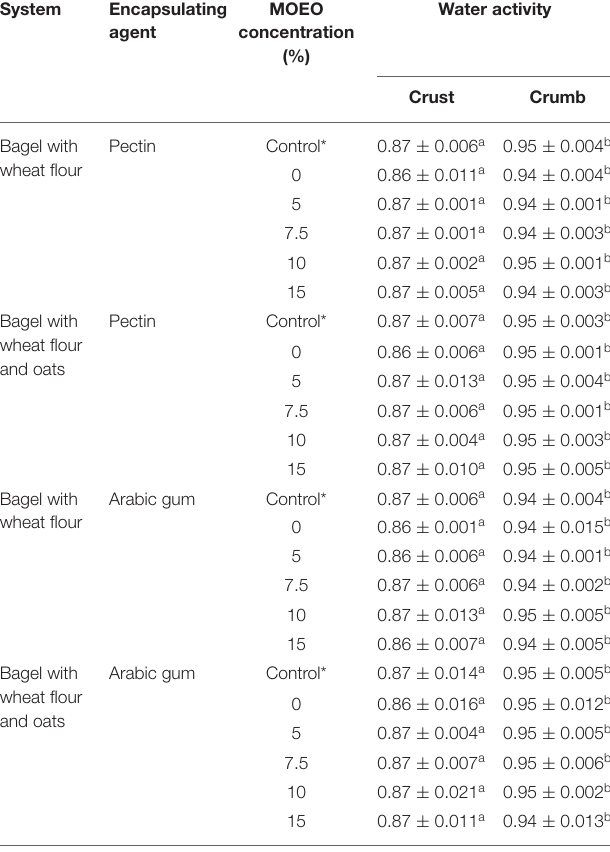
TABLE 4 | Water activity of crust and crumb of different formulations of bagels atomized with emulsions stabilized with pectin or Arabic gum at different concentrations of Mexican oregano essential oil (MOEO) stored at 25 ◦